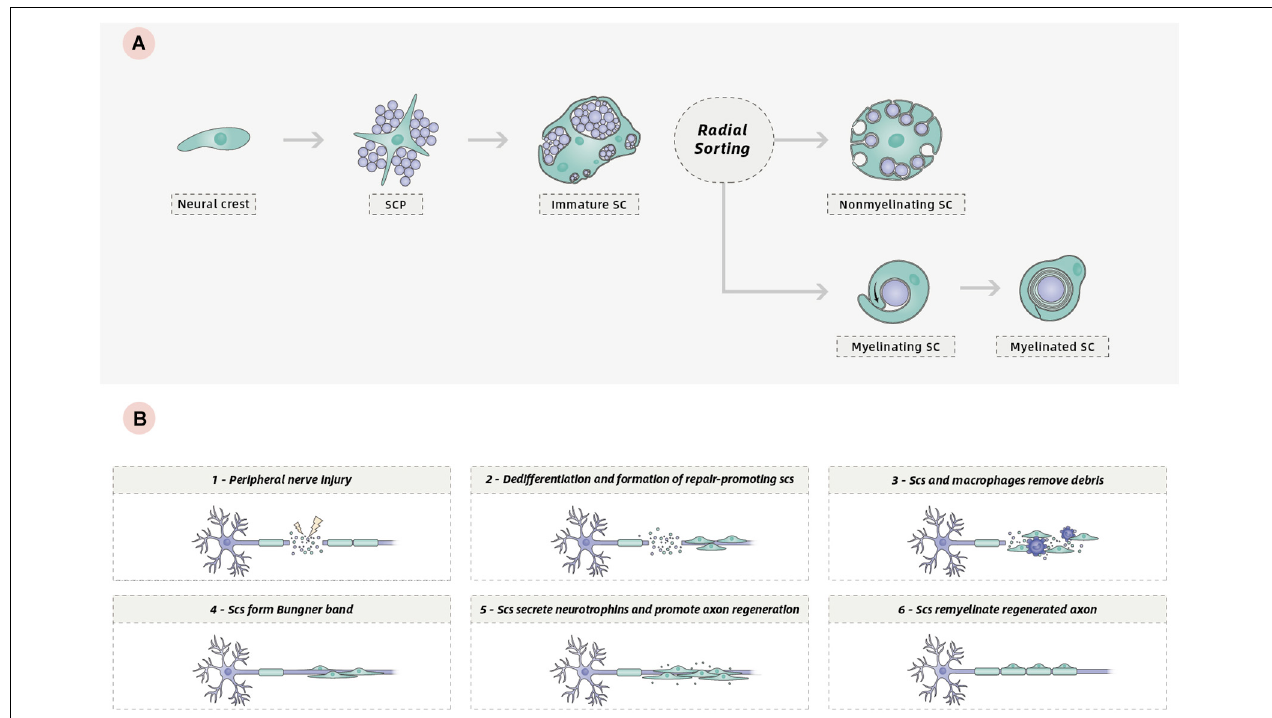
FIGURE 1 | (A) Development of the SC lineage: from neural crest cells to myelinating and non-myelinating SCs. (B) Schematic of the repair program orchestrated by SCs following peripheral nerve